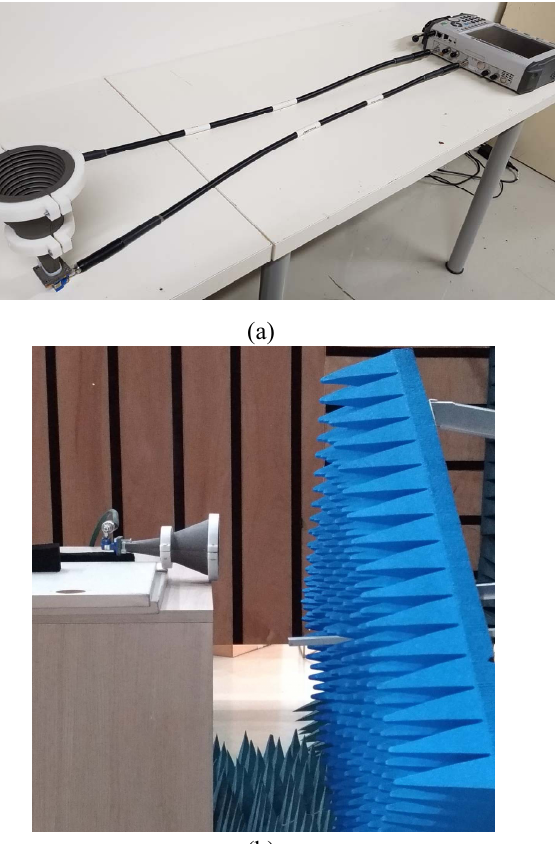
Figure 7: The photographs of the measurements in (a) Yasar University (b) TUBITAK